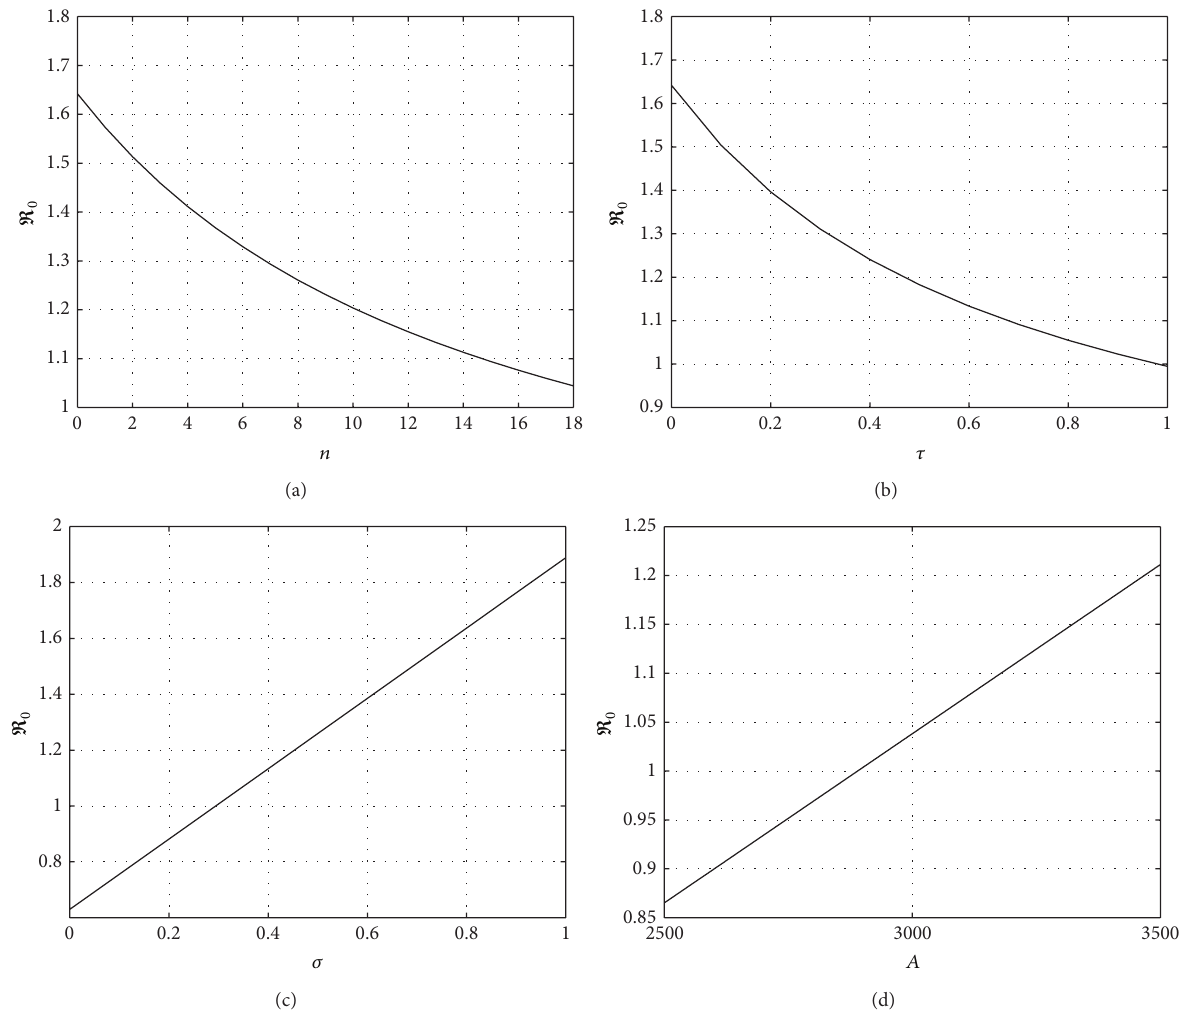
Figure 3: (a) R 0 in terms of 𝑛 . (b) R 0 in terms of 𝜏 . (c) R 0 in terms of 𝜎 . (d) R 0 in terms of 𝐴 . Other parameters are the same as in Figure